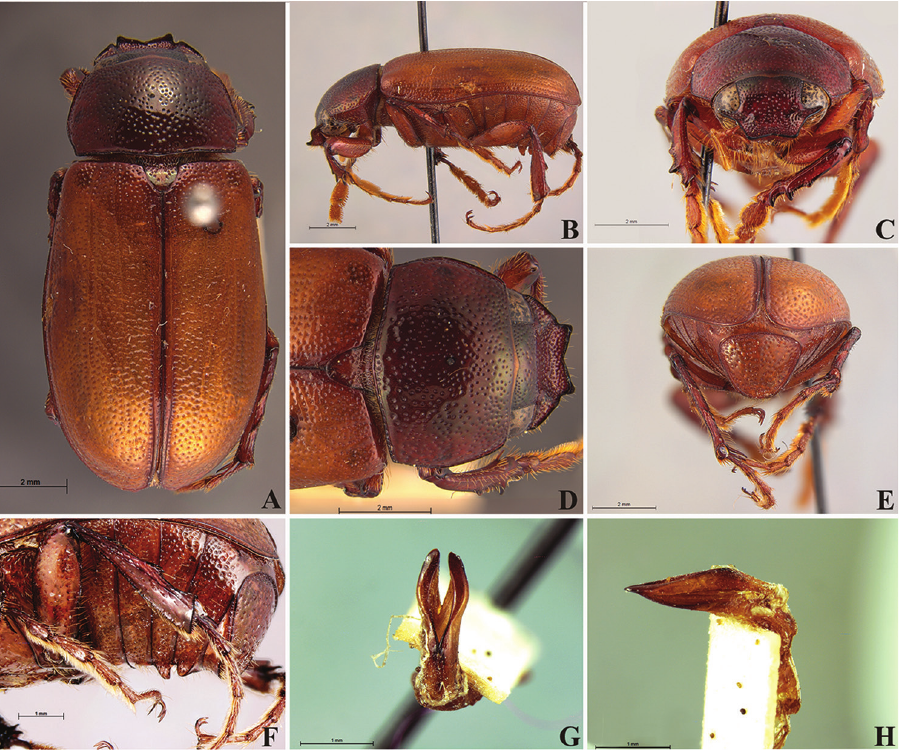
Figure 73. Liogenys spiniventris Moser. A Dorsal view B Lateral view C Frontal view D Clypeus and pronotum E Pygidium F Abdomen, lateral view G Parameres, dorsal view H Parameres, lateral view.